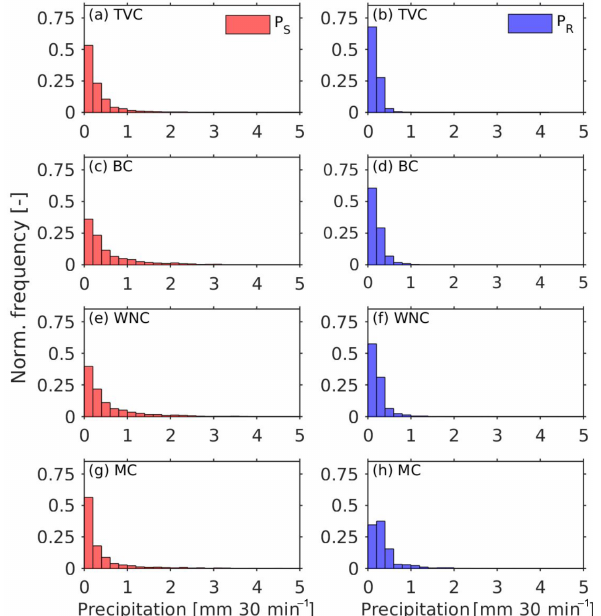
Figure 7. Histogram of 30min rainfall ( P R : left column panels) and snow ( P S : right column panels) at four windy sites (TVC, BC, WNC, and MC). For better visualization for light precipitation, low frequencies of the precipitation over 5mm30min − 1 were cut out.